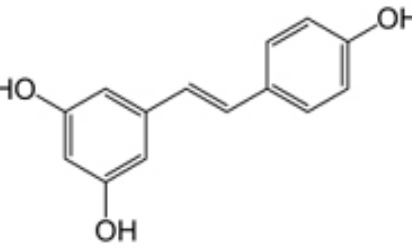
Figure 1. Structure of Trans -resveratrol.